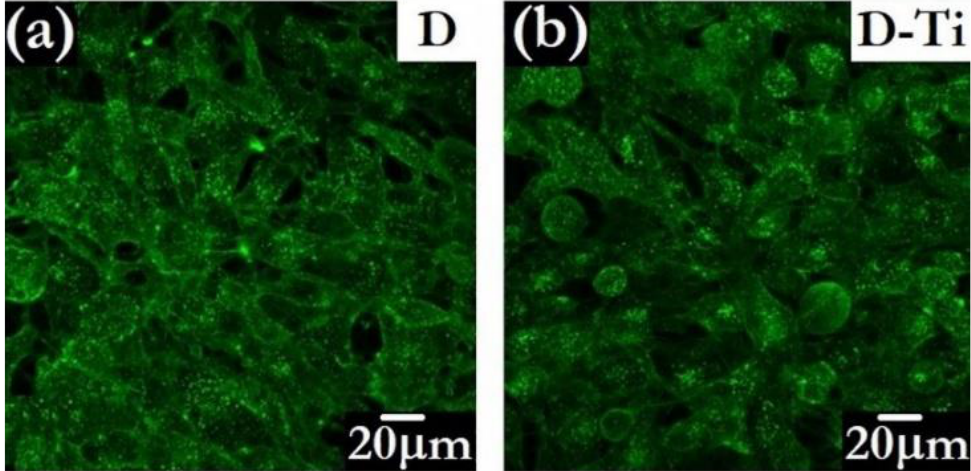
Figure 8. Confocal microscopy images of MG 63 cells grown for 4 days on undoped diamond D ( a ) and on Ti-doped D-Ti ( b ) samples (Adapted from Ref. [117]).